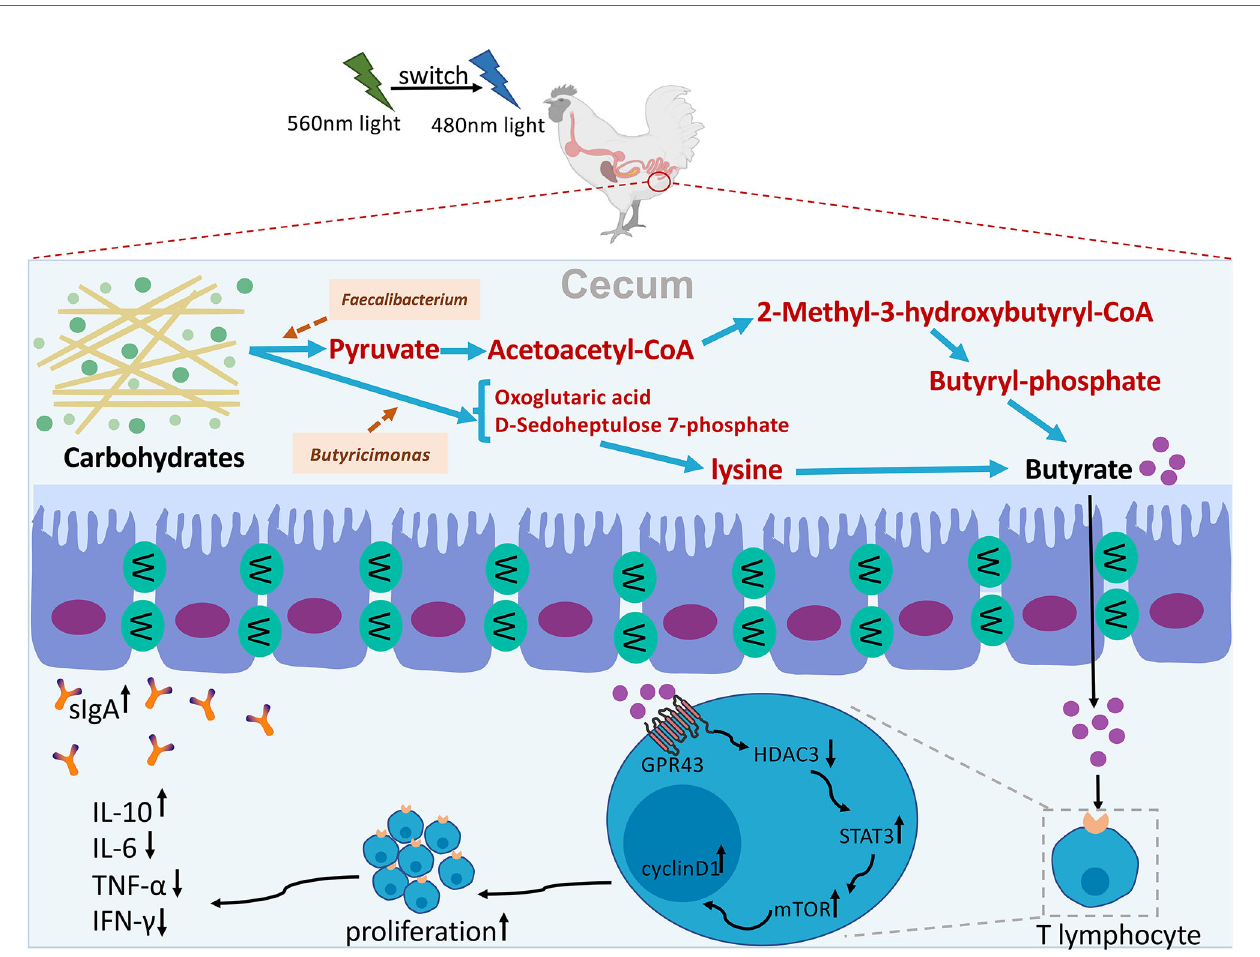
FIGURE 12 | Hypothetical diagram of how G → B mediated cecal microbiome alterations and cecal tonsil T lymphocyte proliferation in chicks. A combination of green and blue monochromatic light indirectly affect the composition of cecal microbiota and increase the relative abundance of Faecalibacterium and Butyricicoccus and butyrate production by reducing the level of oxidative stress in the cecum. Furthermore, butyrate effectively promoted cecal tonsil T cell proliferation through the GPR43/HDAC3/p-STAT3/mTOR pathway in